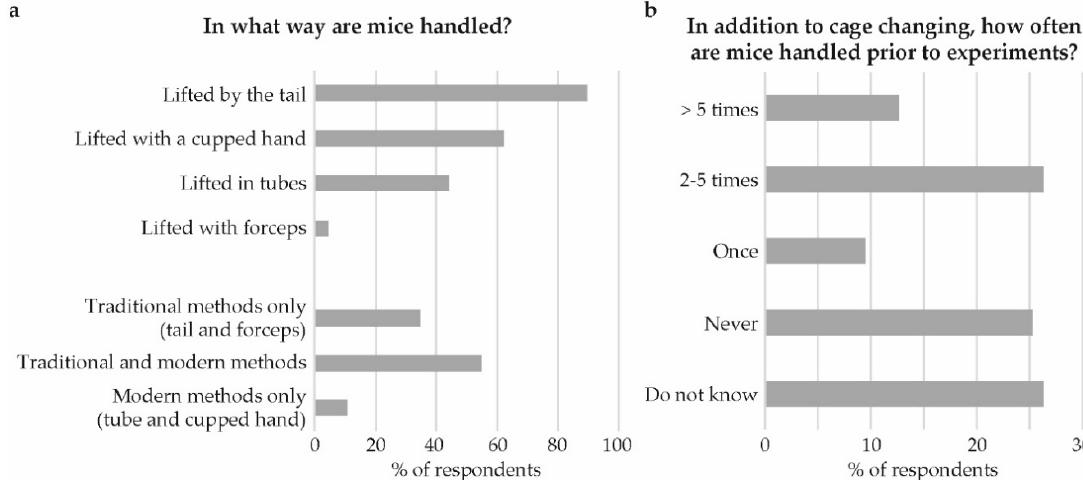
Figure 7. Animal handling. ( a ) In what way are mice handled? And, ( b ) in addition to cage change, how often are mice handled prior to experiments?